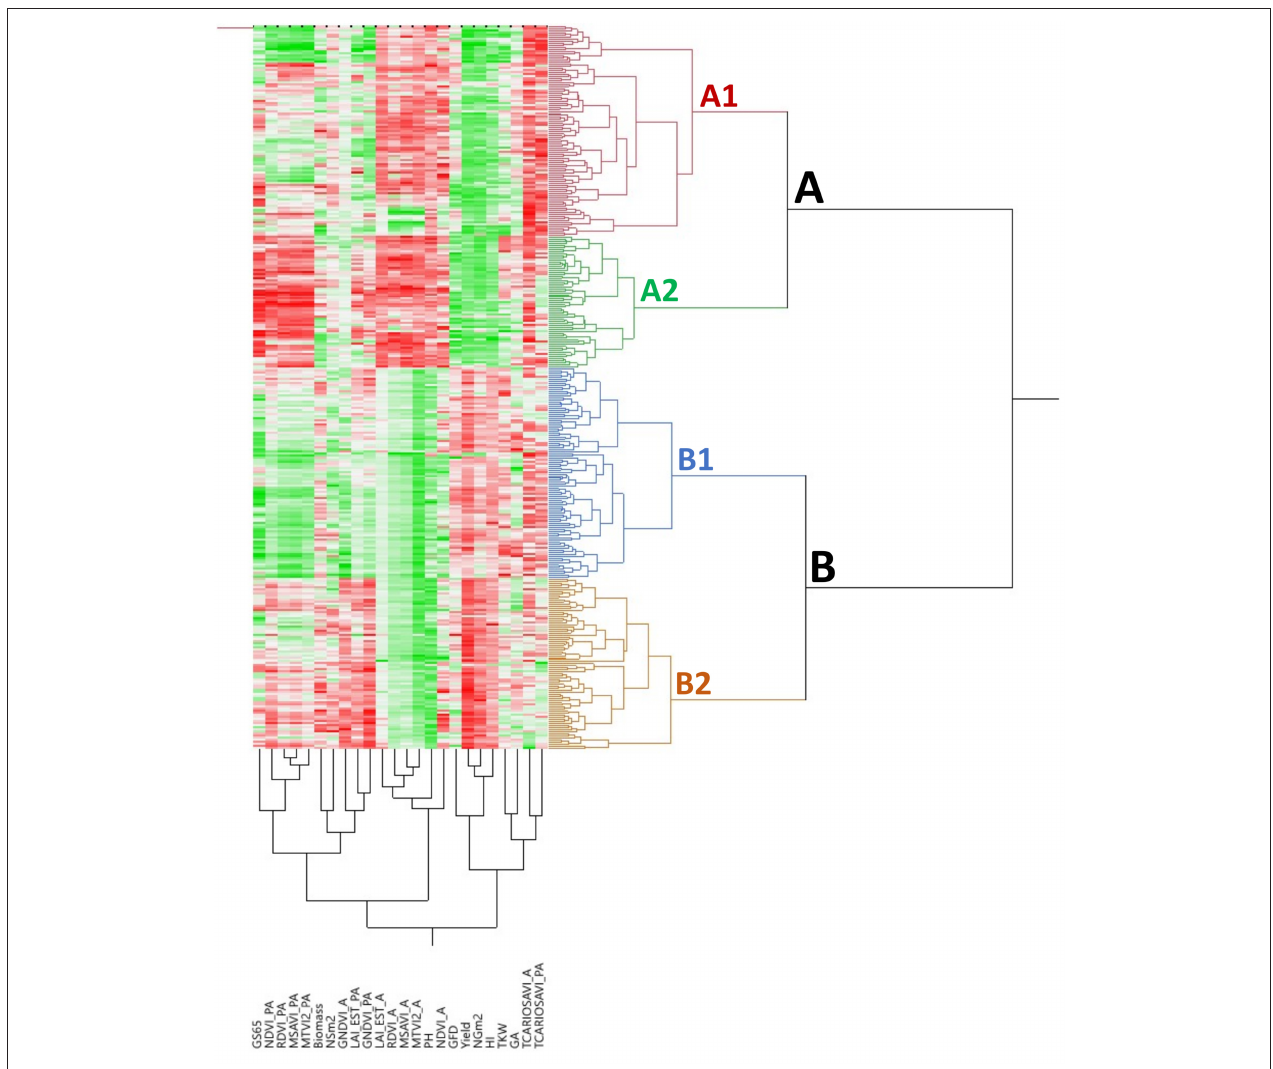
FIGURE 3 | Bidimensional clustering showing the phenotypic relationships between the 354 bread wheat genotypes based on the analyzed traits indicated in the vertical cluster at bottom. Red and green colors in the columns indicate high and low values, respectively. Dark, higher values; light, lower values; white, intermediate